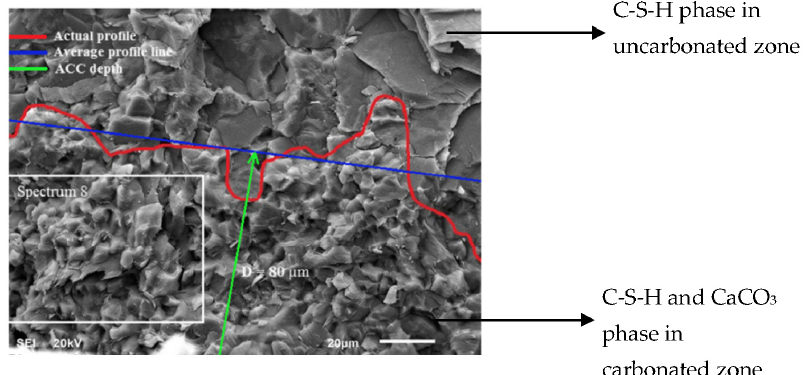
Figure 2. SEM observation of cement paste before ( left ) and after ( right ) carbonation [55].